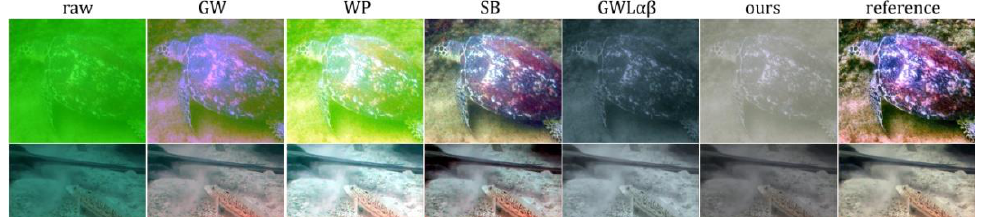
Figure 6. Comparisons on low backscatter scenes. From left to right are raw underwater images, the results of gray-world (GW) method, white-patch (WP) method, statistical-based (SB) method [21], Bianco’s (GWLαβ) method [37], proposed method and reference images.